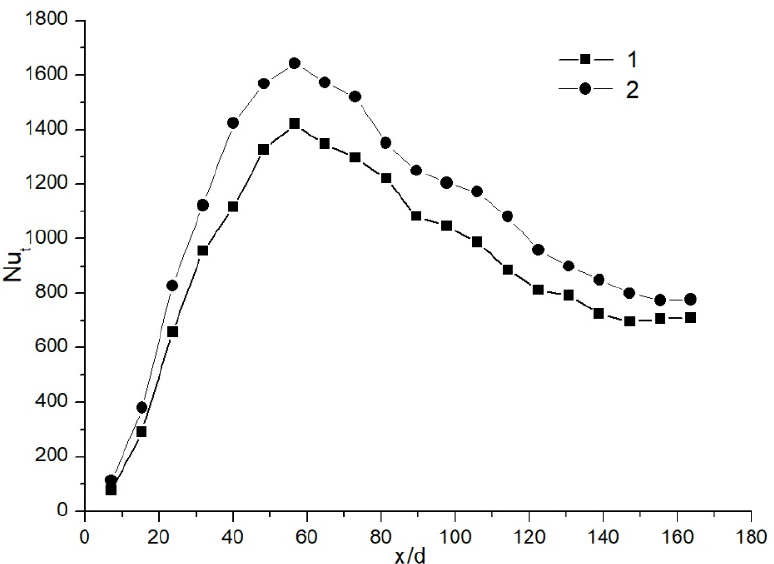
Figure 9. Distribution of the total local Nusselt number along the model of the condensing heat exchanger at Re in ≈ 21,000, different flue gas inlet temperatures: (1) t in ≈ 103 °C, (2) t in ≈ 138 °C.